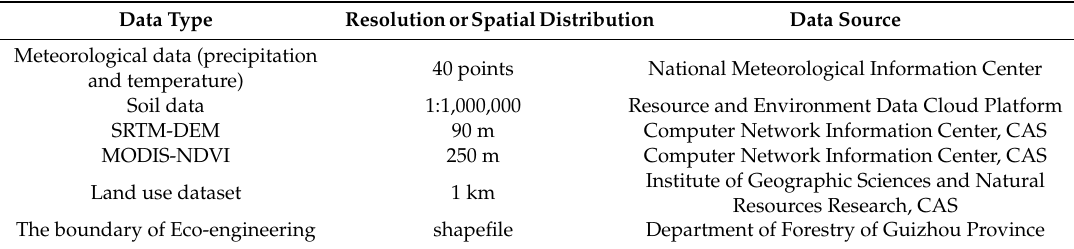
Table 1. Data type, resolution, and